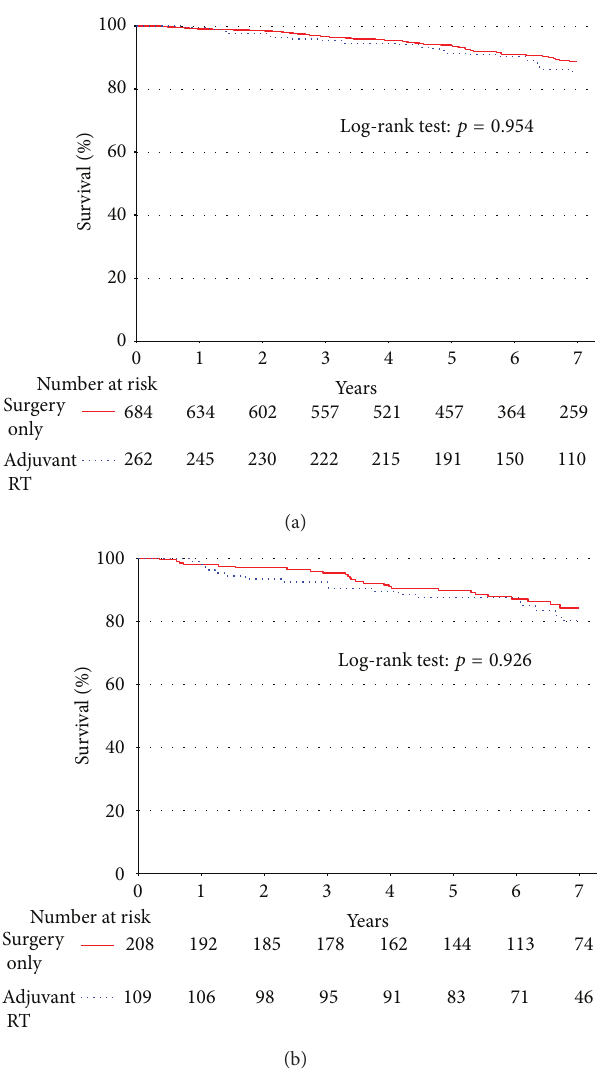
Figure 5: There is no difference in unadjusted survival for (a) patients with well-differentiated liposarcoma when stratified by adjuvant RT versus surgery on the basis of negative margins. There was also no difference when stratified on the basis of positive margins